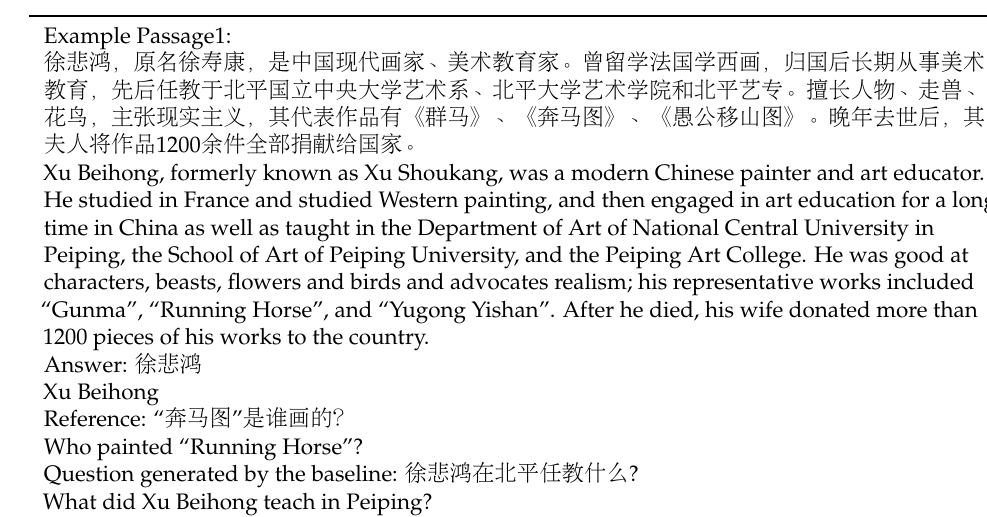
Table 1. Bad case of a current sequence-to-sequence neural approach for question generation based on a long